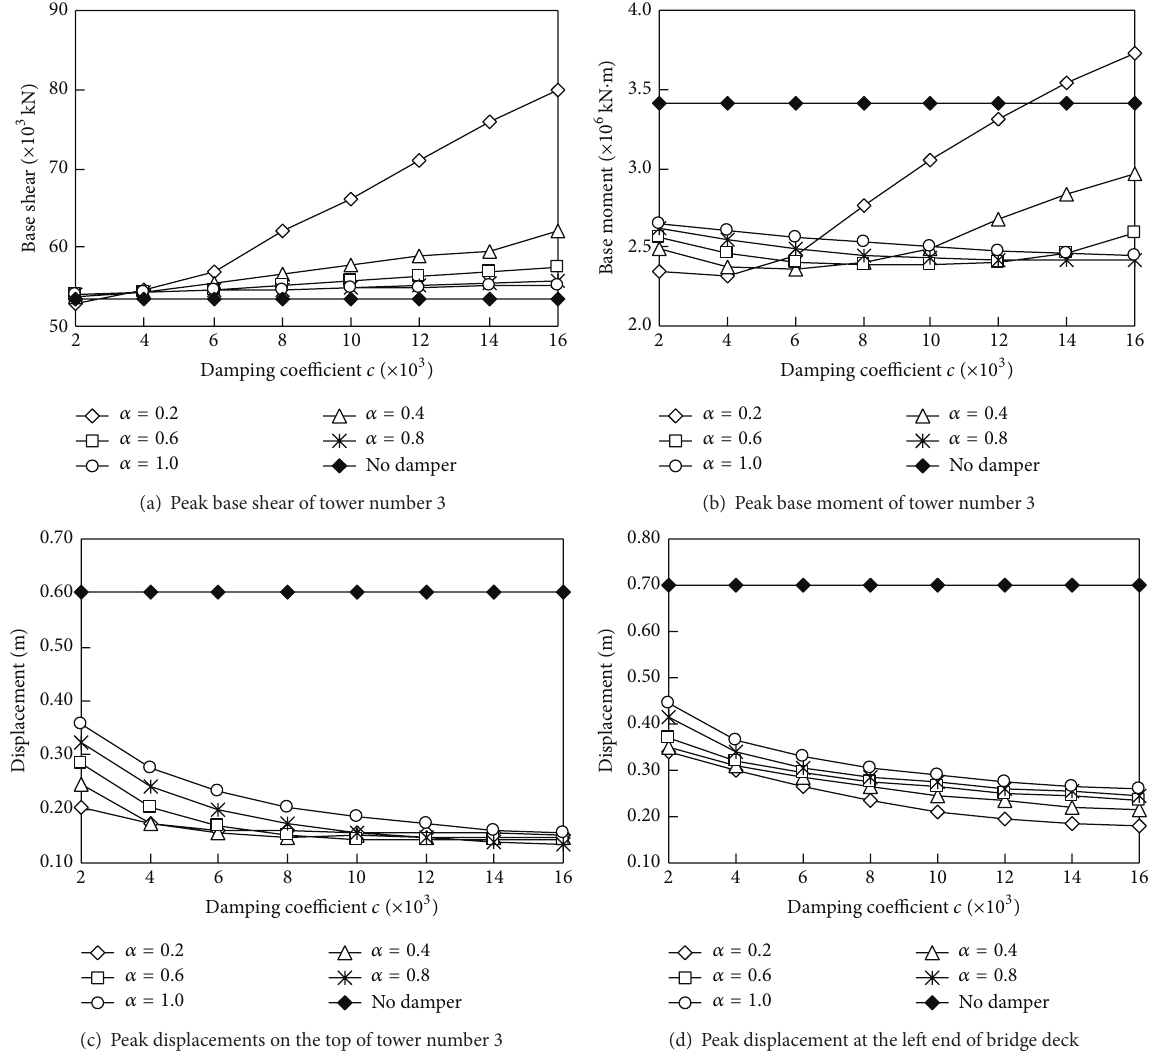
Figure 12: Effects of variations in damping coefficient and velocity exponent of the viscous fluid dampers on the seismic responses of the contrast